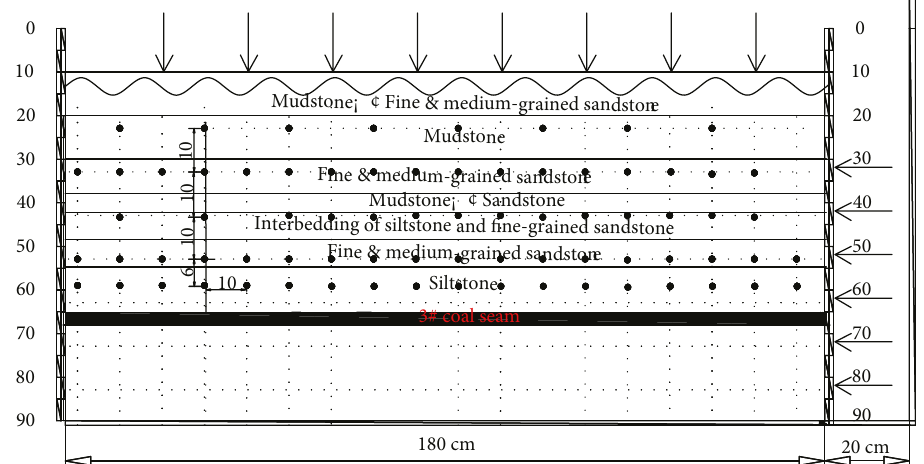
Figure 7: Similar material simulation model. The mining process of the model was monitored, the used for calibration, and the plane displacement monitor- movement of overlying strata during mining and the param- ing grid was arranged on the front side of the model. The eters in the failure state of the overlying strata were recorded, layout of monitoring spots is shown with red dots in and the images were processed. Figure 7.